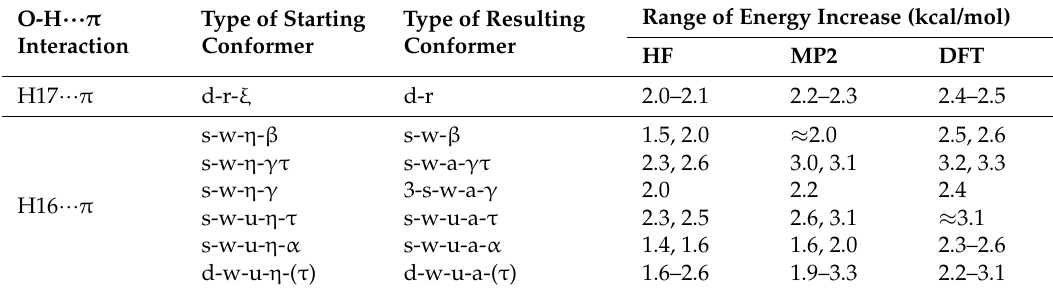
Table 6. Ranges of the energy increase caused by the removal of the O-H ··· π interaction, according to the type of starting and resulting conformers. The calculation methods are denoted with the following acronyms: HF for HF/6-31G(d,p), MP2 for MP2/6-31G(d,p)/HF/6-31G(d,p) and DFT for DFT/B3LYP/6-31+G(d,p). When only two values are available for a given type, they are both reported, separated by a comma, and in the same sequence in the HF, MP2 and DFT columns.